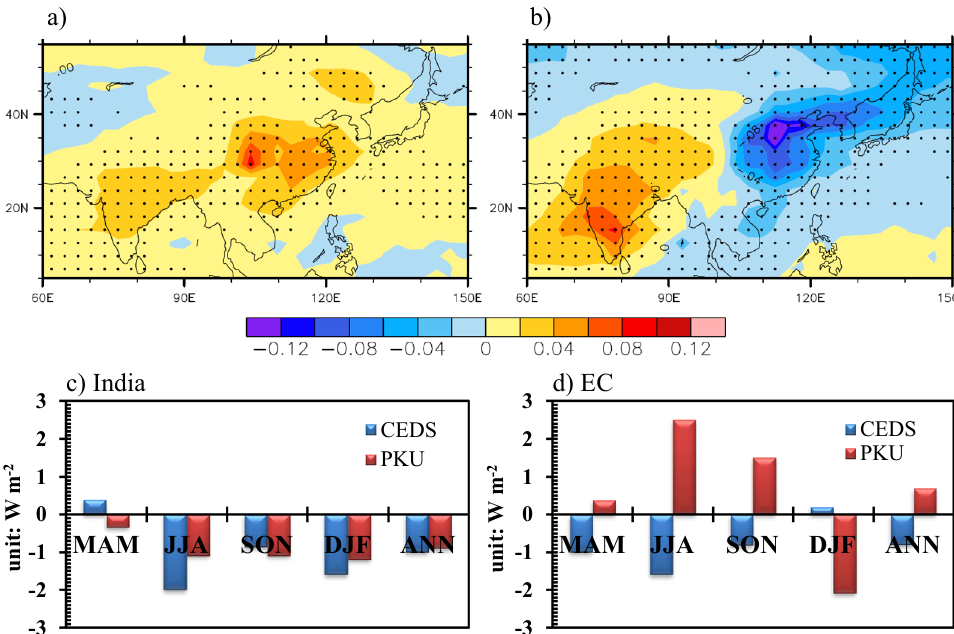
Fig. 3 Simulated changes in AODs and aerosol ERF between 2006 and 2014. a , b Changes in annual mean AODs at 550 nm using a CEDS and b PKU inventories (units: dimensionless). The stippled represent changes that are signi fi cant at 90% con fi dence level using the t test. c , d Seasonal and annual mean anthropogenic aerosol ERFs at the TOA averaged over c India and d EC (units: W m°). MAM, JJA, SON, DJF, and ANN are March to May, June to August, September to November, December to February, and annual means, respectively.